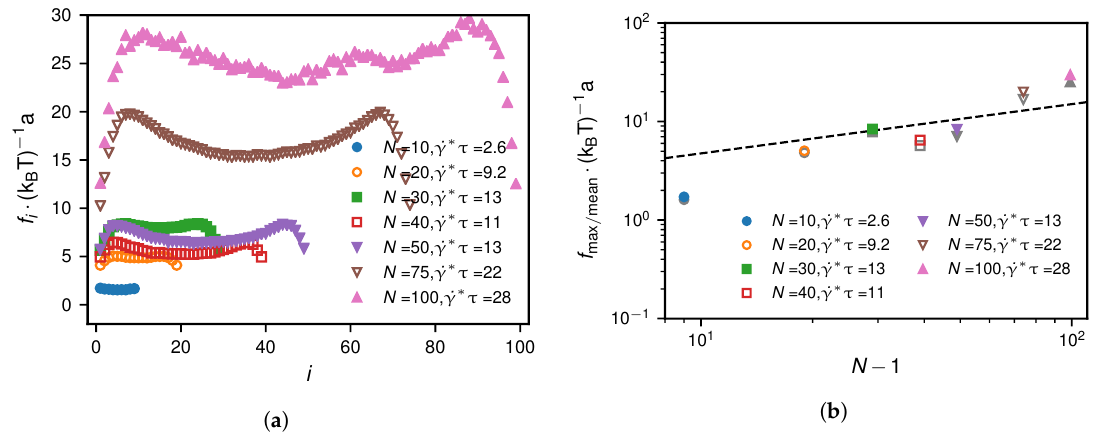
Figure 14. Non-grafted scenario at the critical shear rate ˙ γ ∗ : Subfigure ( a ) shows the tensile force profiles at the critical shear rates for different monomer numbers. In subfigure ( b ) we show the maximum of the tensile force profiles in colour and the mean of the tensile force profiles in grey. For the non-grafted case, the maximum and mean tensile forces are very similar and are described by the same heuristic scaling given by Equation